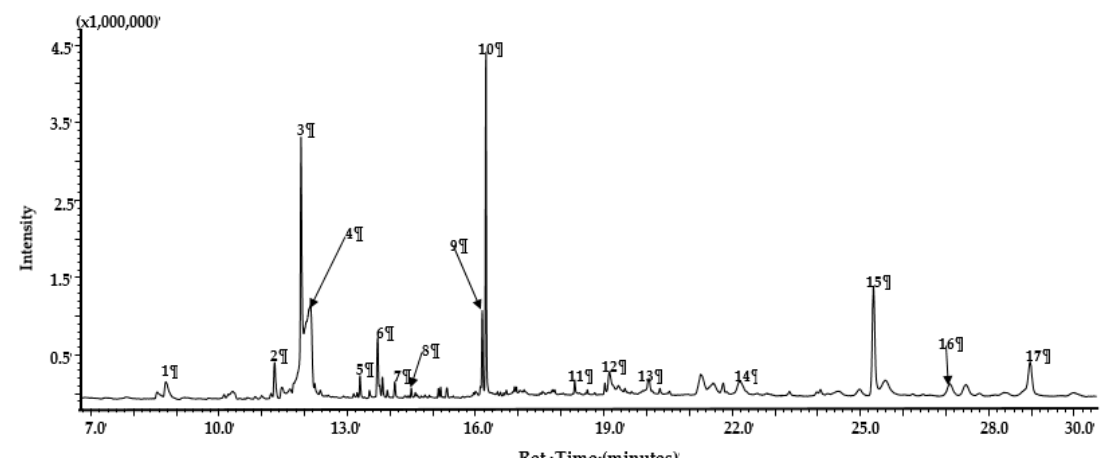
Figure 3. Representative total ion chromatogram (TIC) of the ethanolic extract of Calpurnia aurea . Peak numbers and their identities correspond to those in Table 3.